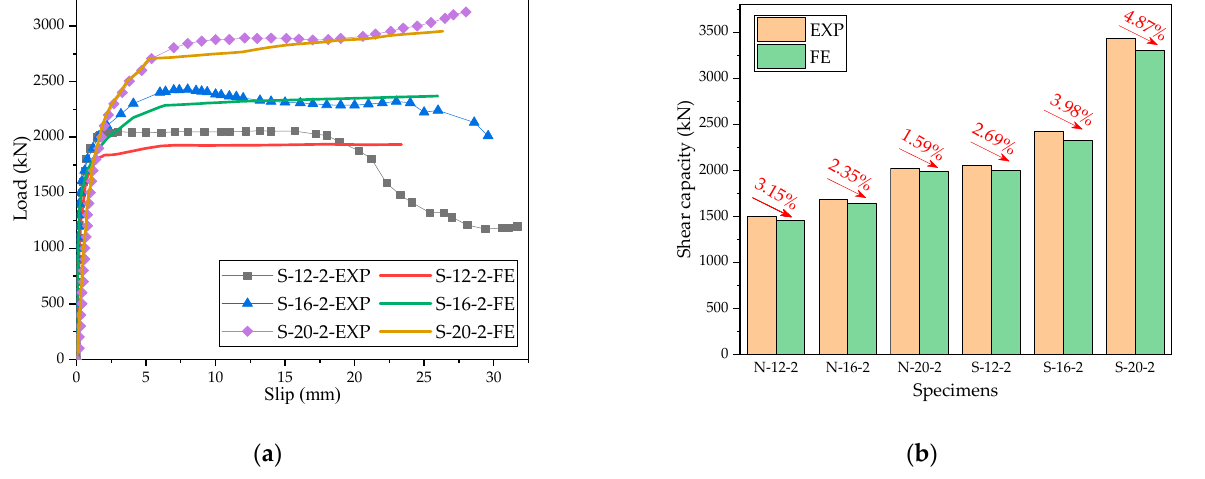
Figure 14. Comparison of experiment and FE results: ( a ) load–slip curves and ( b ) shear capacity.